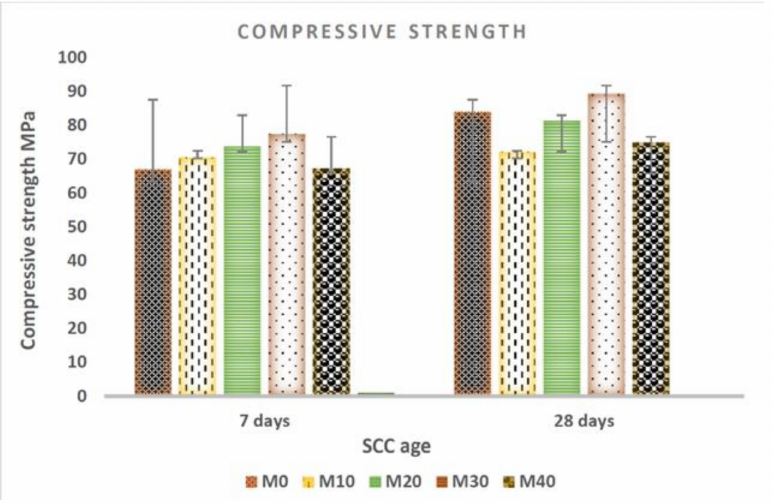
Figure 9. Compressive strength of SCC in different mixtures at 7 and 28